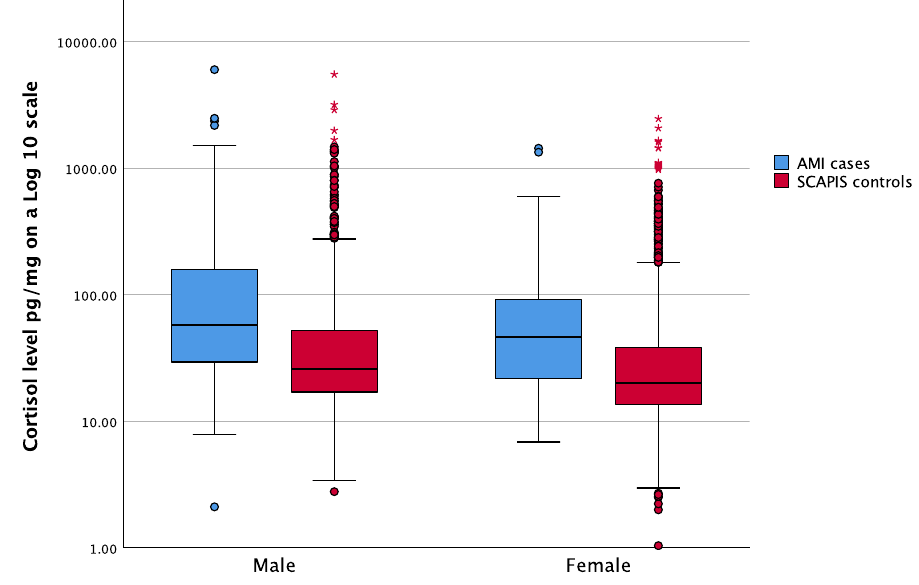
Figure 1. Hair cortisol levels for AMI-cases and SCAPIS-controls.